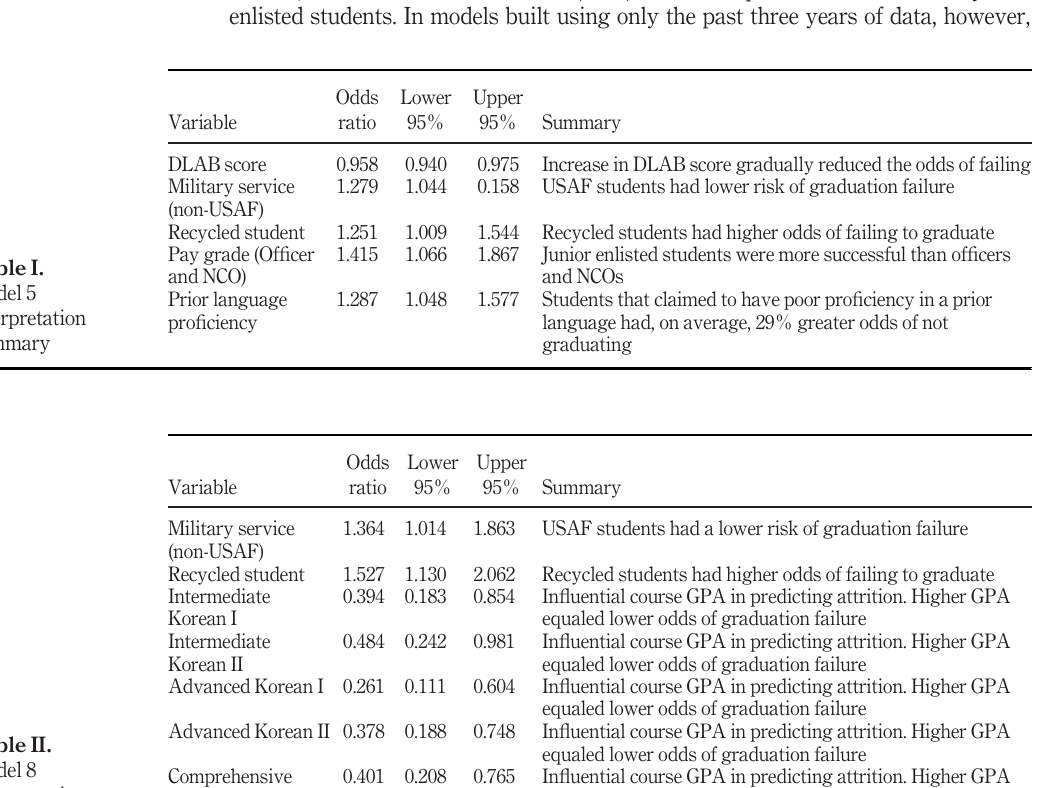
Table II. Model 8 interpretation